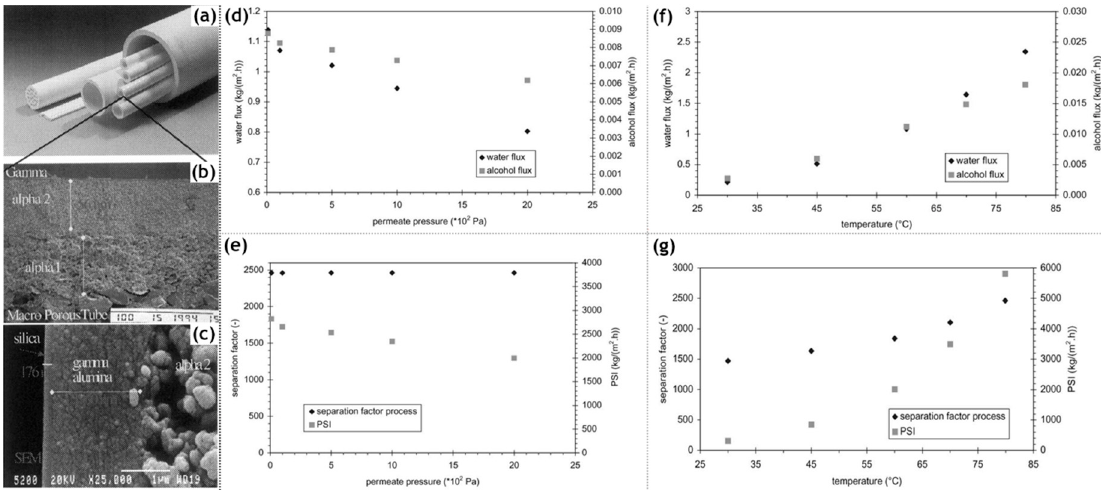
Figure 5. ( a – c ) Scanning electron micrographs of the silica membrane developed by the Energy Research Center (ECN), the Netherlands, adapted from [59] with permission from Copyright (2001), Elsevier Science B.V. ( d ) Alcohol and water flux as well as the ( e ) separation factor and pervaporation separation index (PSI), defined as the product of total flux and separation factor for dehydration of isopropanol as a function of permeate pressure (temperature 60 °C, water content 5 wt%). ( f ) Alcohol and water flux as well as the ( g ) separation factor and PSI for dehydration of isopropanol at different temperatures (30–80 ◦ C, 5 wt% water and permeate pressure of 102 Pa). Adapted from [60] with permission